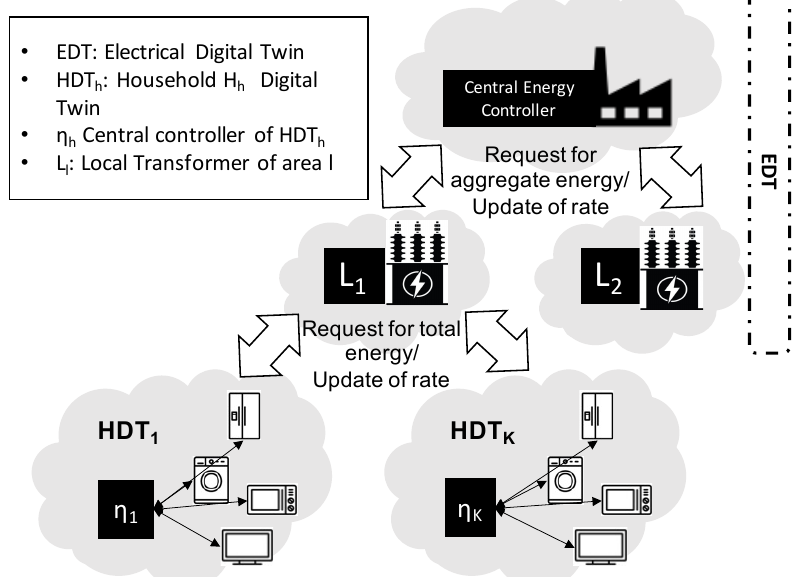
Figure 2. Multi-layered Digital Twin (DT) representation of the system model and data exchange. Each house has an EDT that comprises its local transformer connected to a central energy